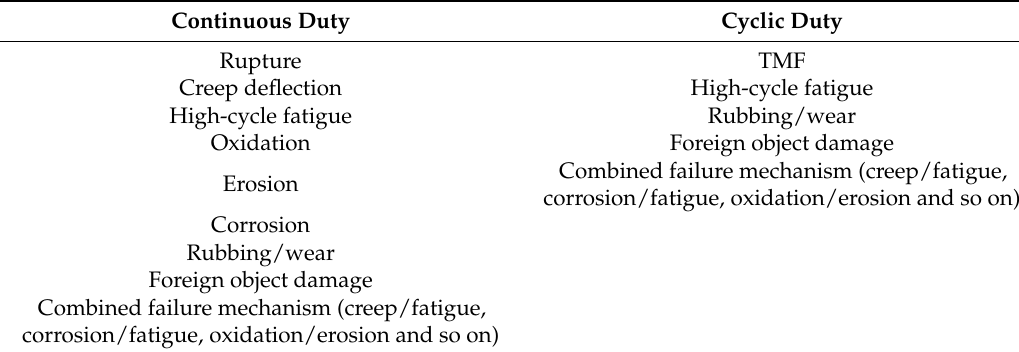
Table 1. Typical failure modes for hot gas components inside a gas turbine.